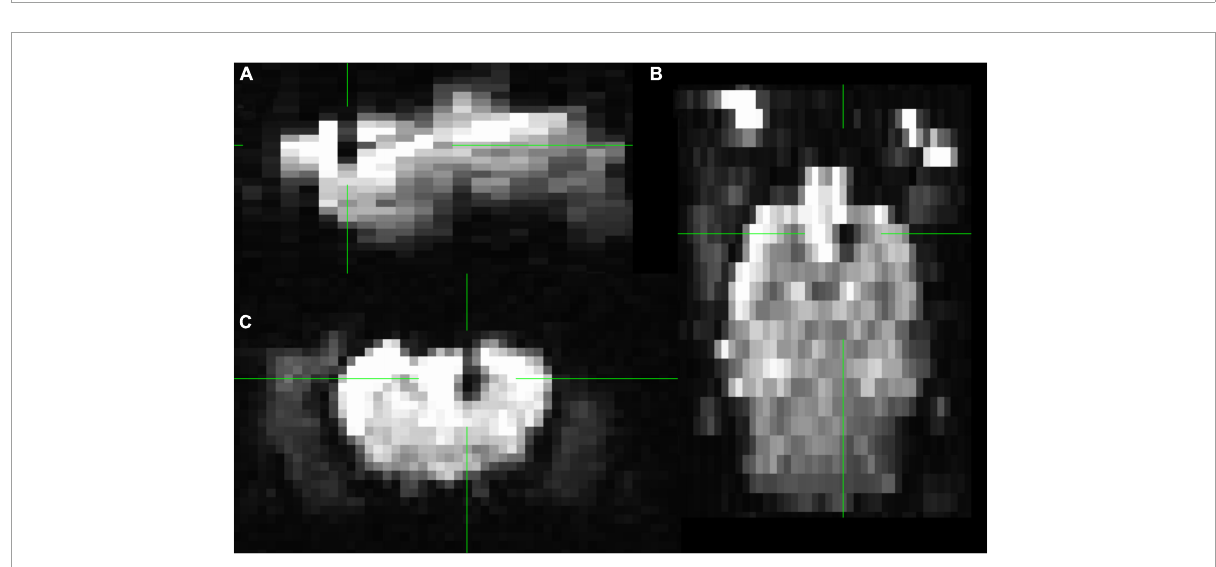
FIGURE6 Functional MRI of rat 2. In the middle of the green markers, the black shadow of the artifact induced by the carbon fiber is seen, without affecting the areas surrounding the electrode. Slices (A) sagittal (B) axial (C) coronal. Group GE EPI sagittal view is shown in Supplementary Figure 3